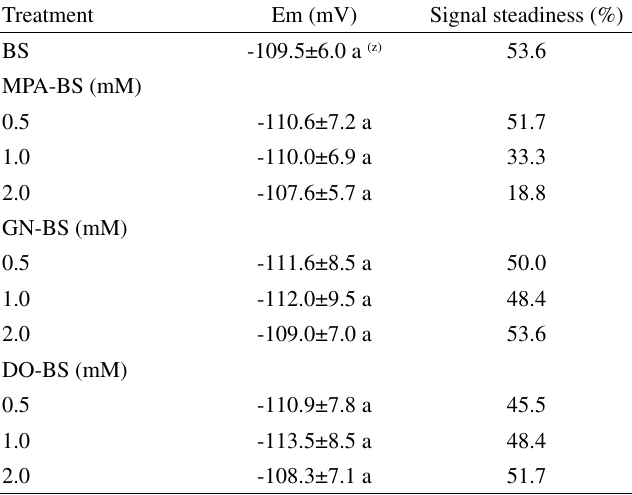
Table 2 - Effect of sample preincubation with chemical administered at different concentrations (0.5, 1.0, 2.0 mM) on membrane potential (Em, mV) or membrane potential signal steadiness on samples of Vitis vinifera cv. Sangiovese, expressed as % of successful microelectrode impalement Treatment